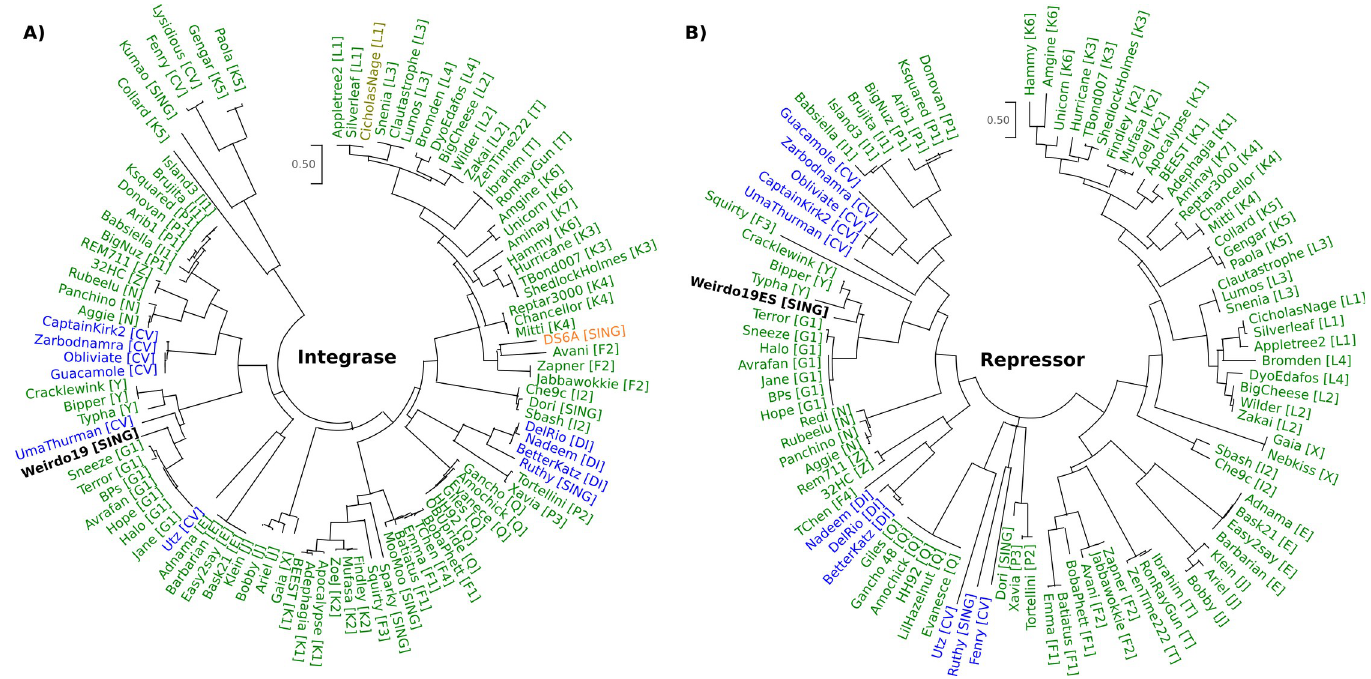
Fig 3. Phylogenetic analysis of the integrases and repressors. The multiple sequence alignment of the integrases and repressors were performed using MUSCLE and the evolutionary history was inferred by using Maximum Likelihood method; both analyses were conducted by MEGAX. Circular dendrograms depict the phylogenetic relationships between integrases A), and repressors B). The graphics were colored by host where M . smegmatis , G . terrae and M . tuberculosis phages are shown in green, blue and orange, respectively, and Weirdo19ES is shown in black.